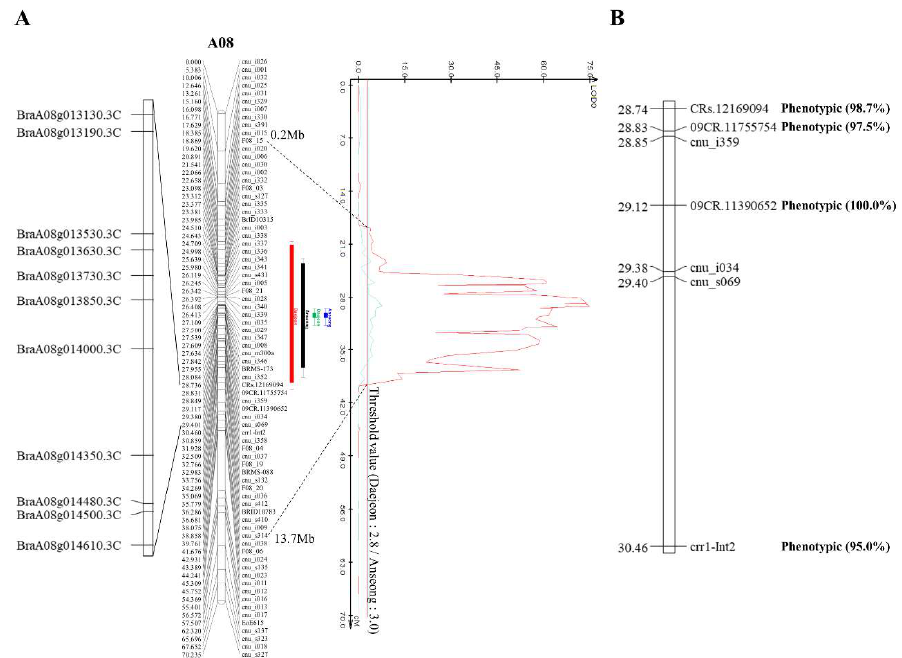
Figure 3. The linkage map of chromosome A08 and QTL, PbBrA08 Banglim , for clubroot resistance traits to the Plasmodiophora brassicae Banglim pathotype in doubled haploid population of B. rapa . ( A ) The PbBrA08 Banglim in the genetic map and candidate genes. In genetic map, genetic distances are shown on the left side of linkage group as centi-morgans (cM), and the markers are located on the right side of linkage group. On the right side of genetic map is QTL result. On the left side of map represented the candidate genes are represented, located in the overlapping detected QTL region analyzing WinQTL cartographer 2.5 and IciMapping 4.1. The rectangular bars of red and black color represented the QTL region, analyzed by WinQTL cartographer 2.5 and discovered in year replicates, respectively. The green and blue color bar show QTL detected by IciMapping 4.1. ( B ) shows closely linked markers to the resistance loci to Plasmodiophora brassicae Banglim pathotype. The value inside of parenthesis represented the identification ratio of phenotype by markers, respectively. Table 2. Summary of QTLs detected for clubroot resistance against the Banglim pathotype of P . brassicae using composite interval mapping (CIM). LOD—logarithm of odds. Table 3. Identification of related resistance genes within the PbBrA08 Banglim region in B . rapa